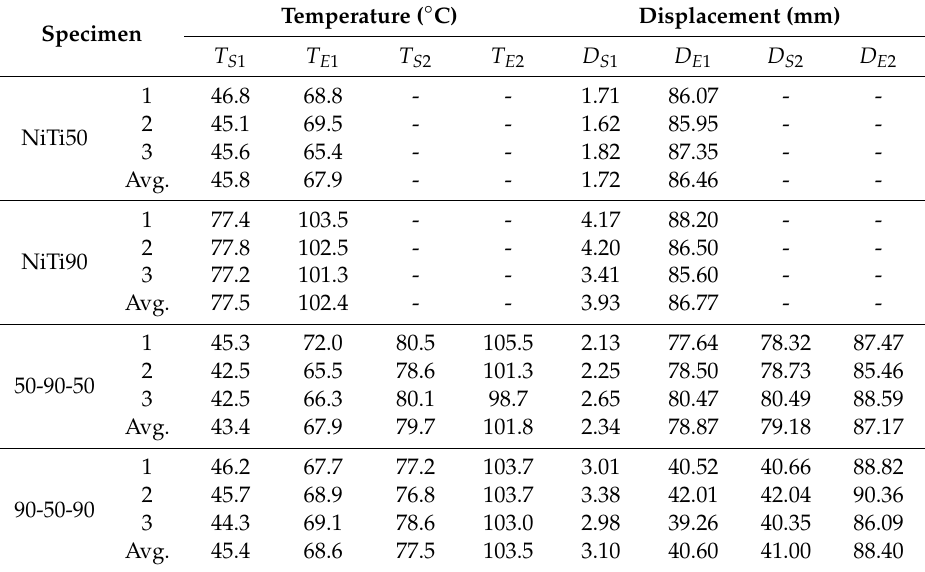
Table 3. Comparisons of results of shape recovery